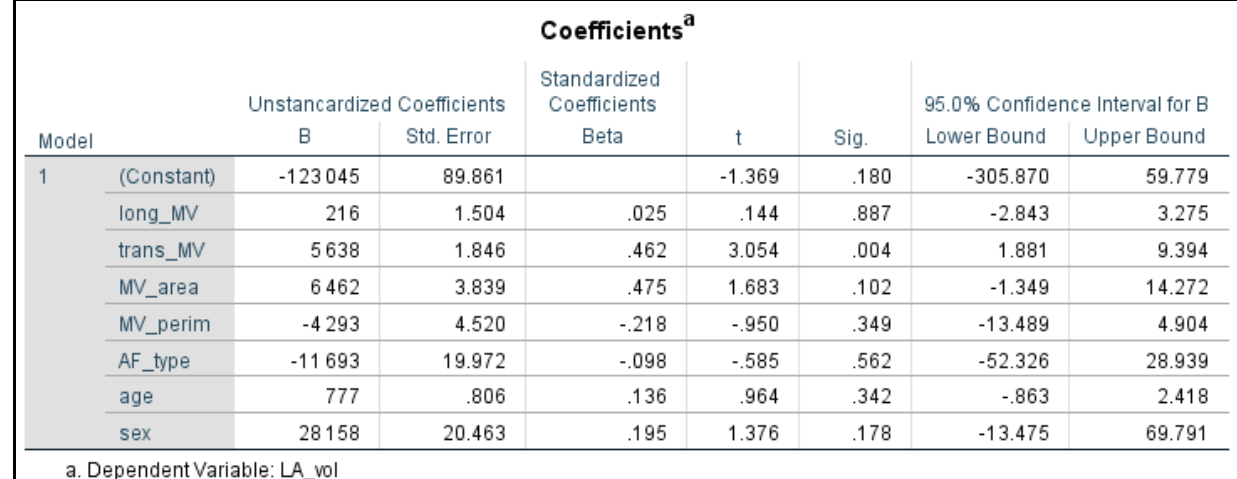
Figure 5. In multivariate analysis only the transverse diameter of the mitral valve ( p = 0.004, 95% CI = 1.8 – 9.4) was inde- pendently associated with LA volume.